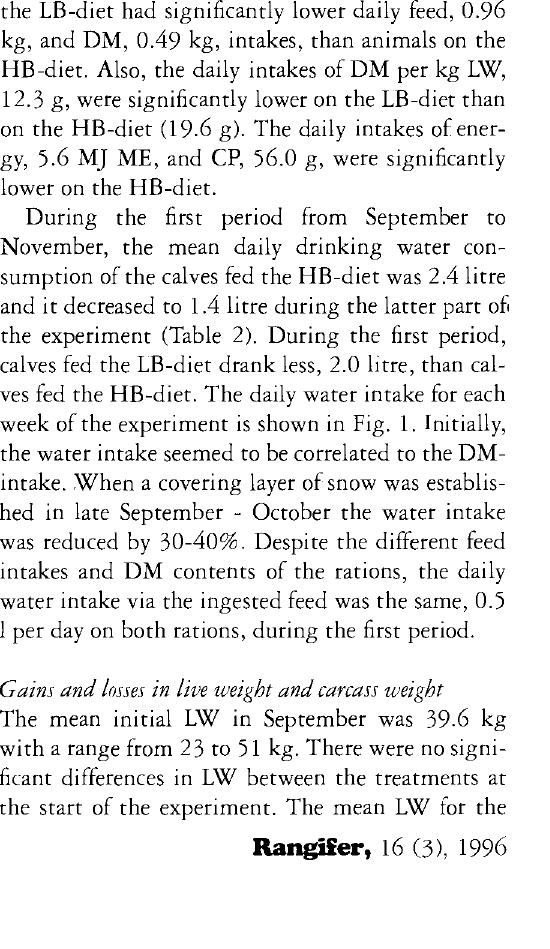
the silage and barley were 43.2% and